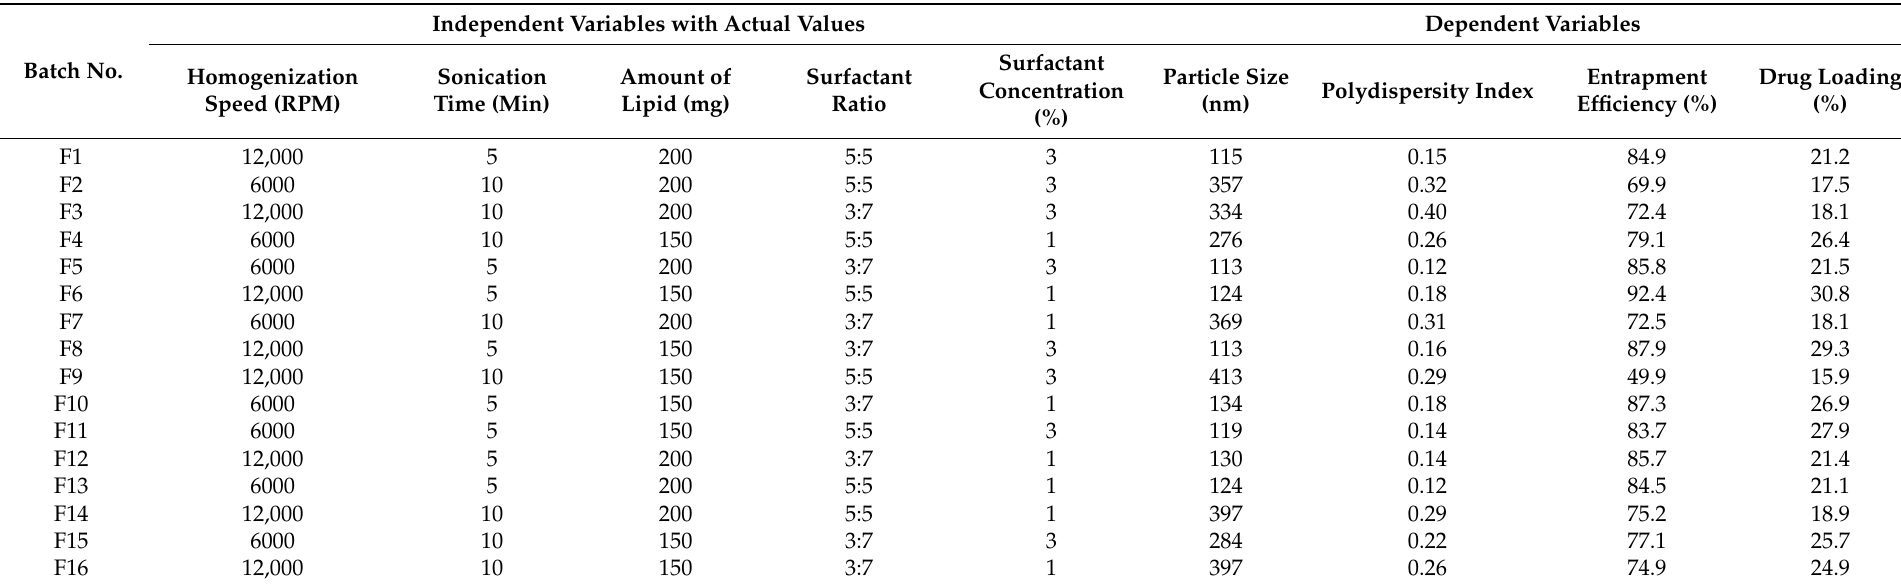
Table 5. Evaluation of fractional factorial design